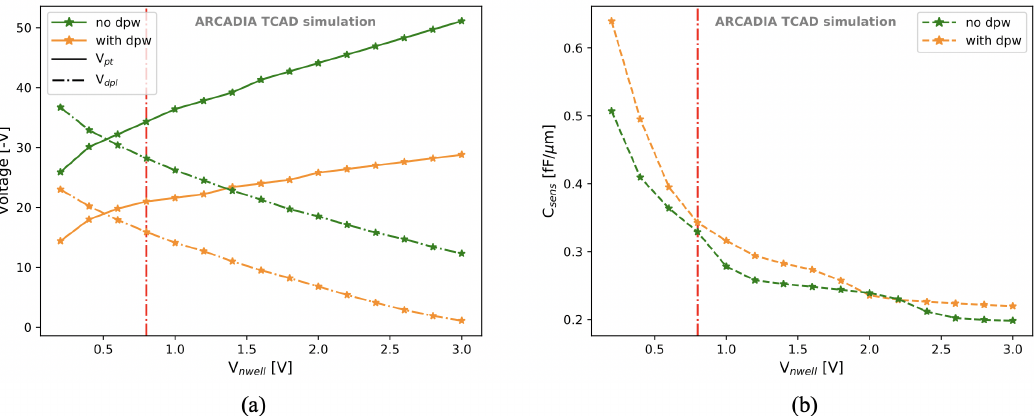
Figure 20. V dpl and V pt ( a ) and sensor capacitance ( b ) as a function of V nwell . The vertical red line indicates the default value of V nwell =